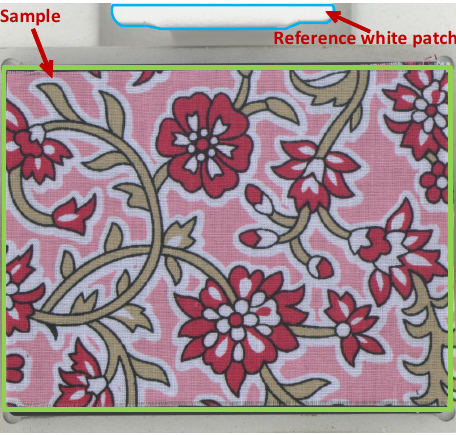
Figure 2. The layout of the small reference white patch and an imaged sample. The white patch is marked by a blue line, and the sample is marked by a green